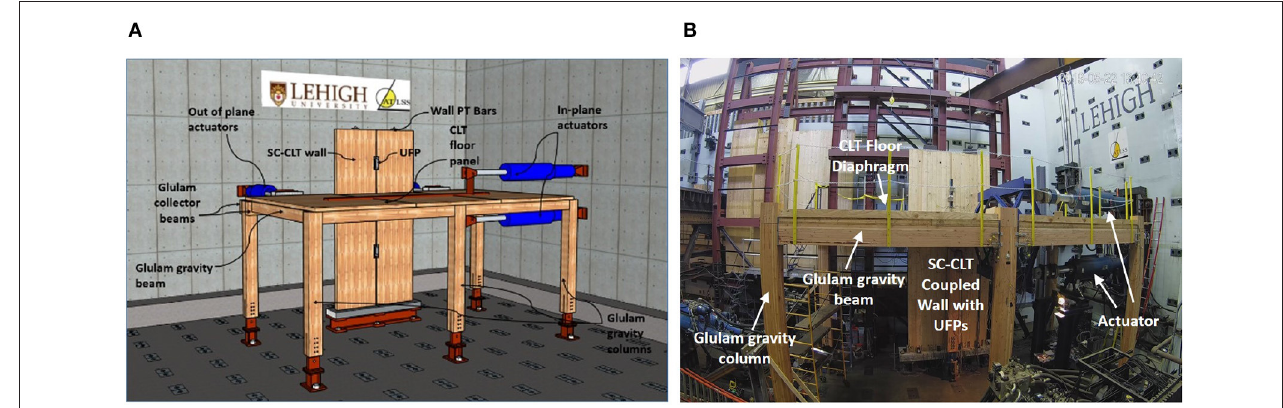
FIGURE 13 | Multi-directional test of cross-laminated timber self-centering coupled walls-floor diaphragm-gravity system: (A) schematic and (B) test setup (courtesy of Amer, 2021).